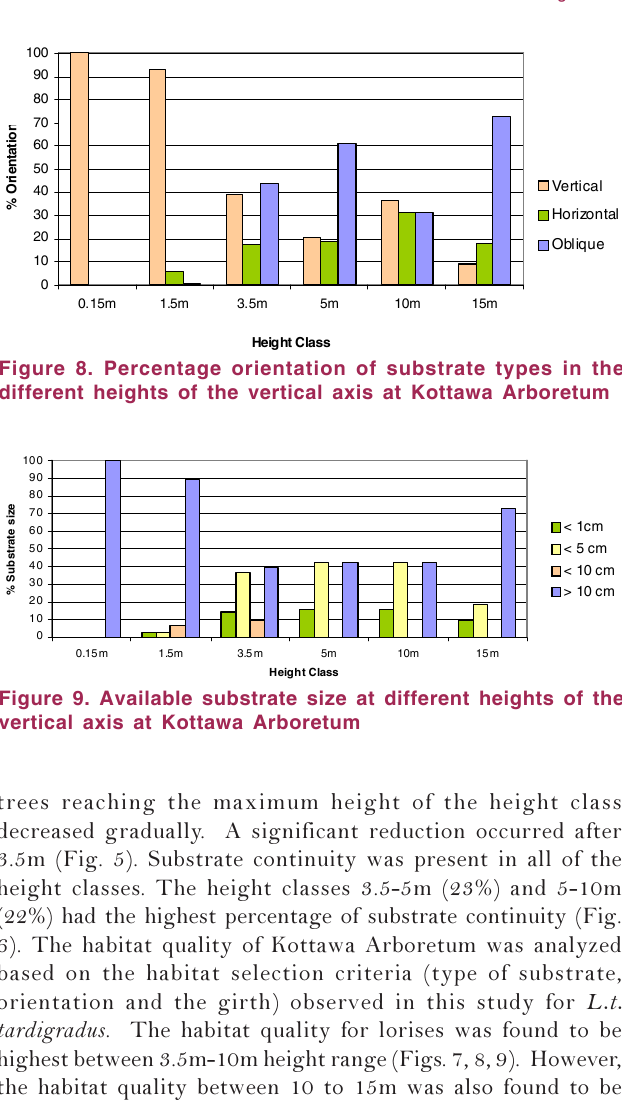
Figure 6. Percent substrate continuity at different height classes in the Kottawa Arboretum